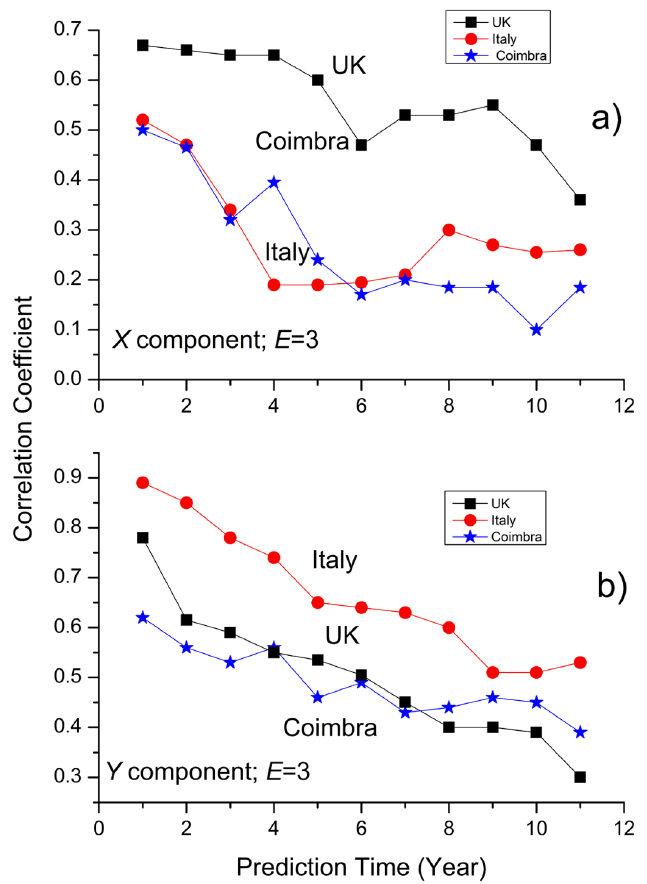
Figure 1. Correlation coefficients between the predicted (a) and observed (b) values of the X and Y geomagnetic time series of three European ob- servatories when reconstructed in a phase space (adapted from Barra- clough and De Santis [1997]). The decrease in time is a symptom for a chaotic geomagnetic field. E = 3 is the embedding dimension of the re- constructed phase